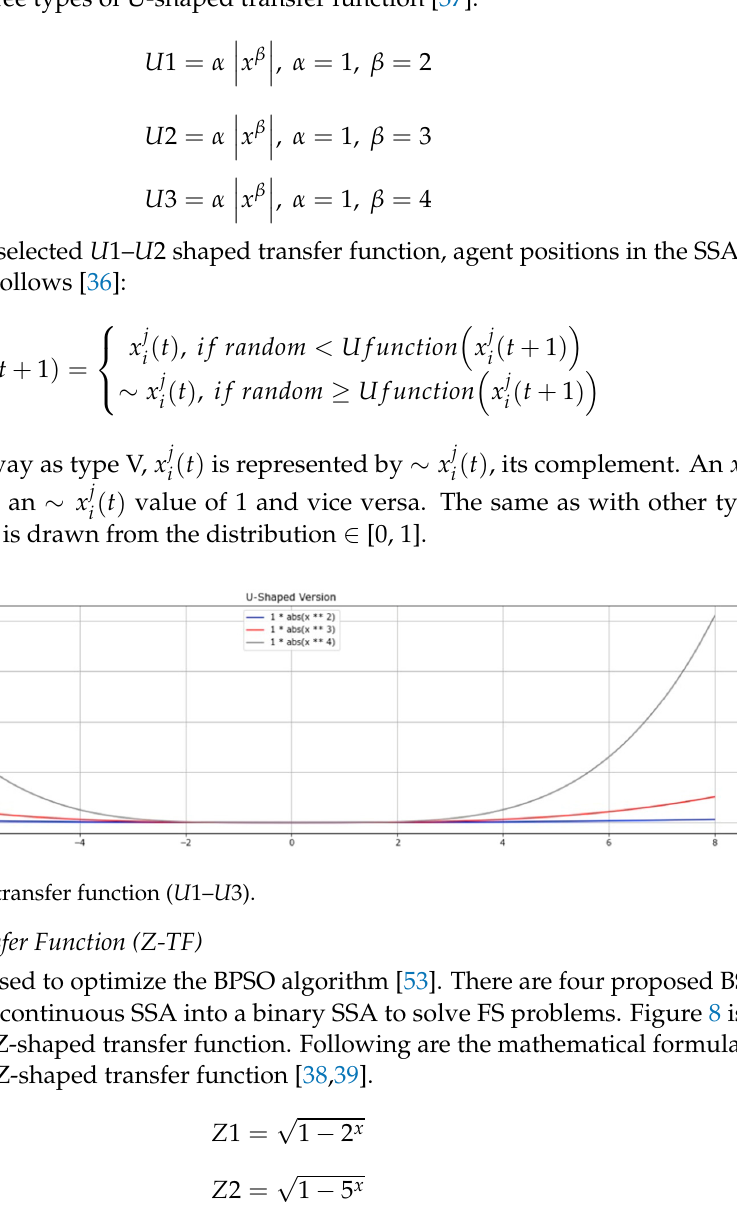
Figure 6. X-shaped transfer function ( X 1– X 2).